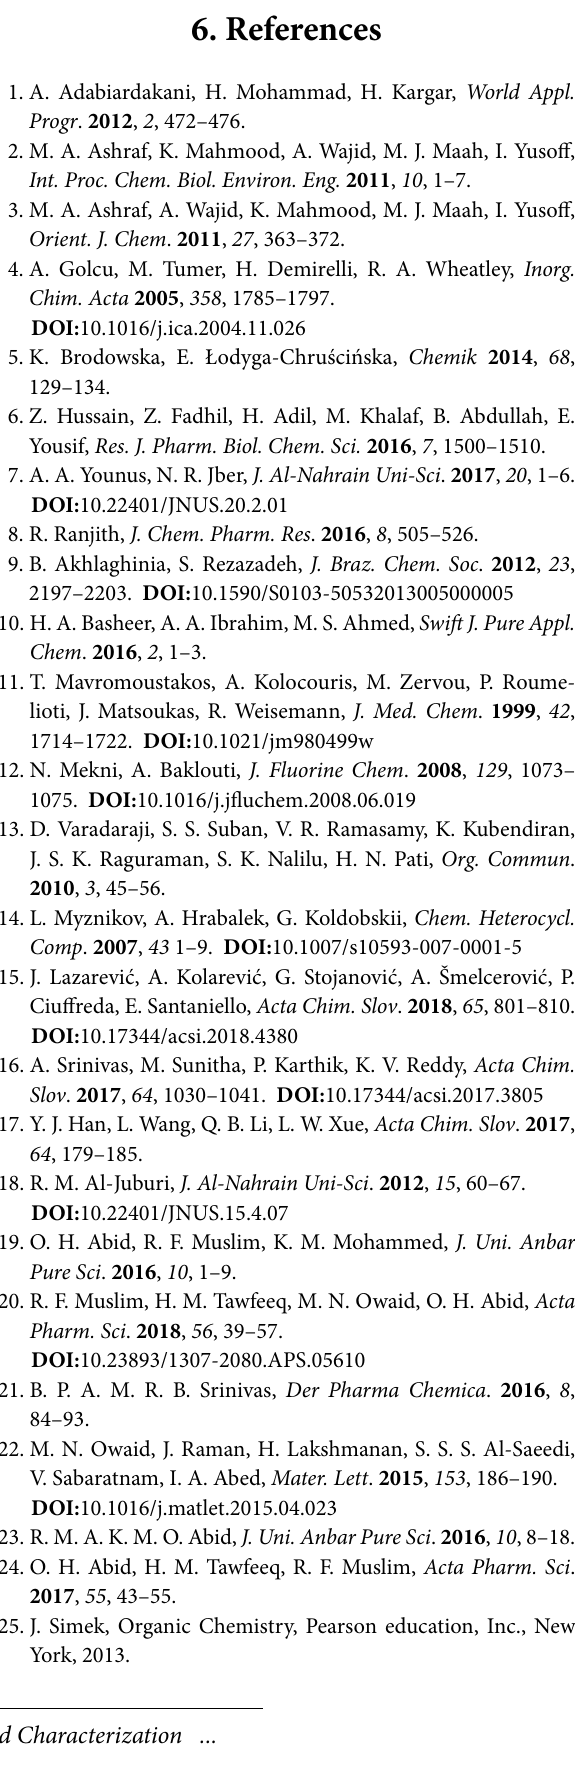
Tawfeeq et al.: Synthesis and Characterization ...